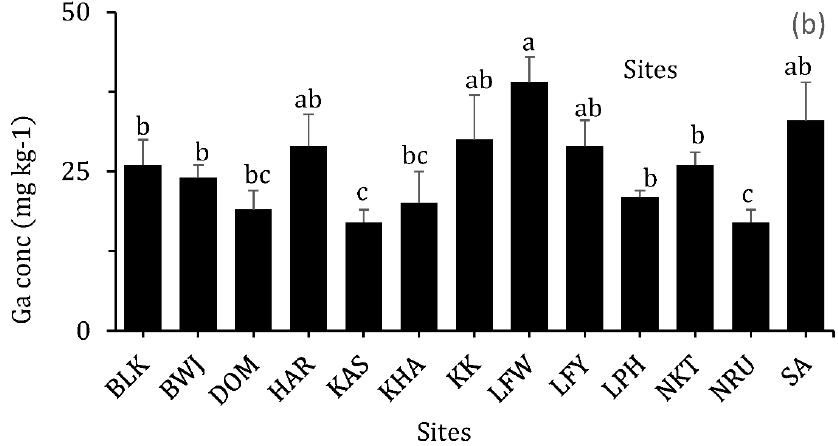
Figure 5. Metal(loids) concentrations in soils of paddy fields of various sites showing ( a ) U and ( b ) Ga concentrations evaluated by site. BLK: Balaka (17), BWJ: Bwanje (15 and 16), DOM: Domasi (18), HAR: Hara (3), KAS: Kasinthula (20), KHA: Khanda (19 and 19b), LFY; Lufiliya (1 and 2), LFW: Lifuwu (11), LPH: Limphasa (5 and 6), NKH: Nkhate (21 and 22), KK: Nkhotakota (7–9), NRU: North Rumphi (4), and SA: Salima (10, 12–14). Bars that share common letters (a, b, c) are not significantly